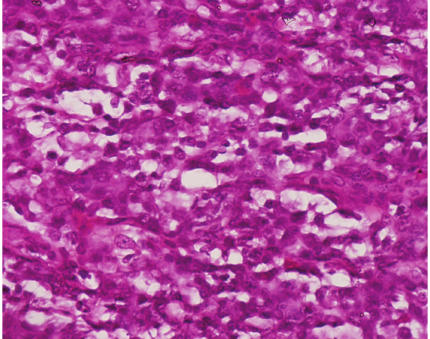
Figure 2: Histopathology showing the typical appearance of “starry sky” with multiple medium-sized highly mitotic